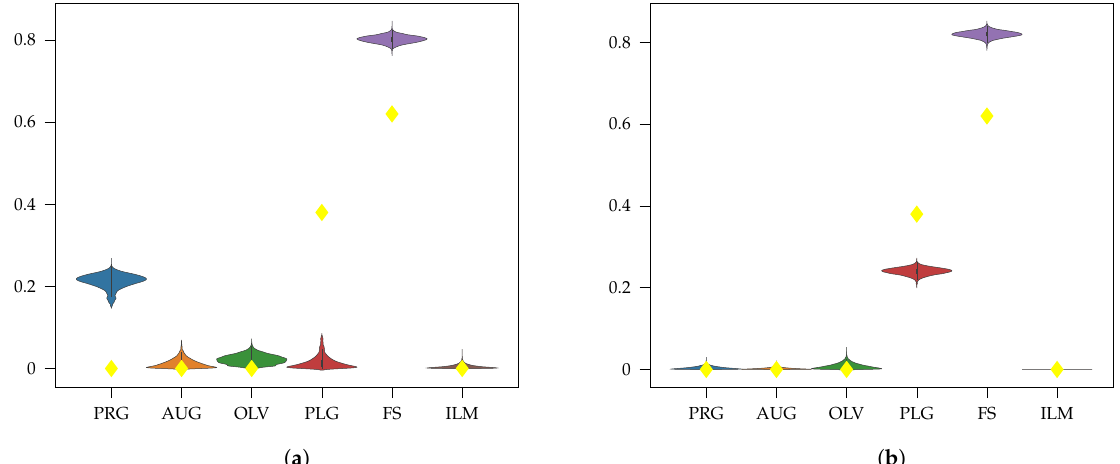
Figure 17. Violin plots for mix 10 of the fresh laboratory mixtures. Yellow diamonds mark the theoretical abundances that were used for mixing the endmembers. ( a ) Without prior; ( b ) TiO 2